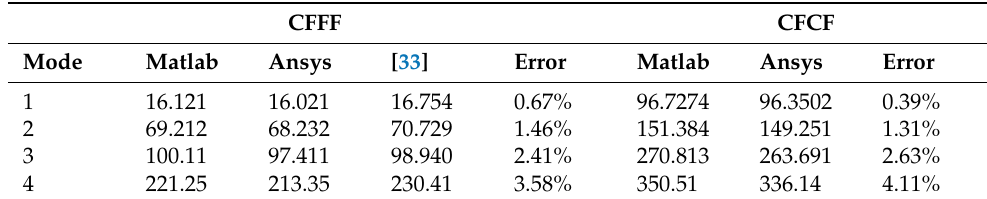
Table 2. Comparison of natural frequencies of ACLD sandwich plates under different boundary